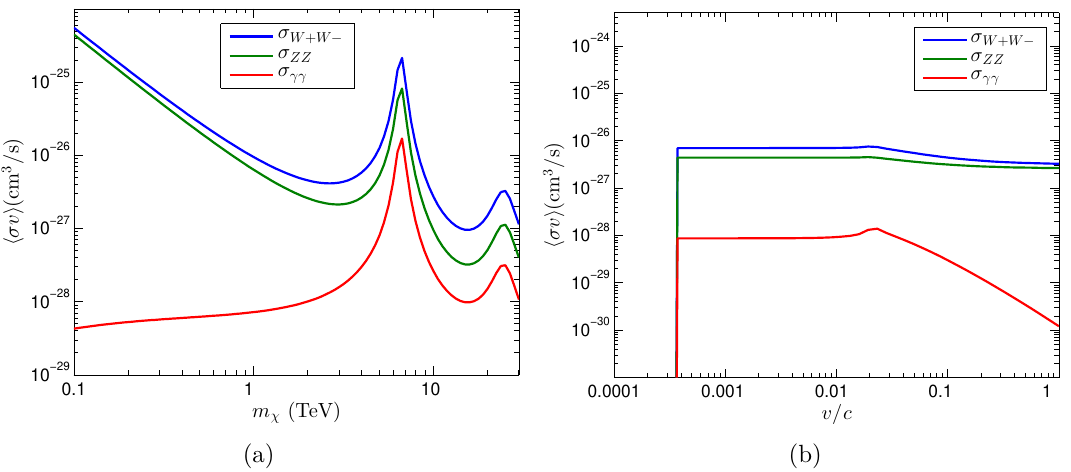
Figure 3. Annihilation cross-section into independent channels W + W − (blue), ZZ (green) and γγ (red) in pseudo-real doublet representation. Left panel (3(a)) illustrates the of χ 0 χ 0 initial state spectrum with respect to the mass at MW halo velocity v = 10 − 3 c , while the right panel (3(b)) depicts the changes for χ 0 χ 0 pair as a function of DM velocity at thermal mass of m 0 = 1 . 2 TeV. e e Annihilation amplitudes for spin-less charged pairs is computed